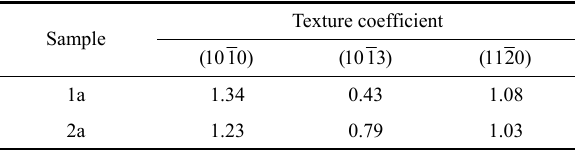
Table 3 Texture coefficient results for the two fully crystalline thin